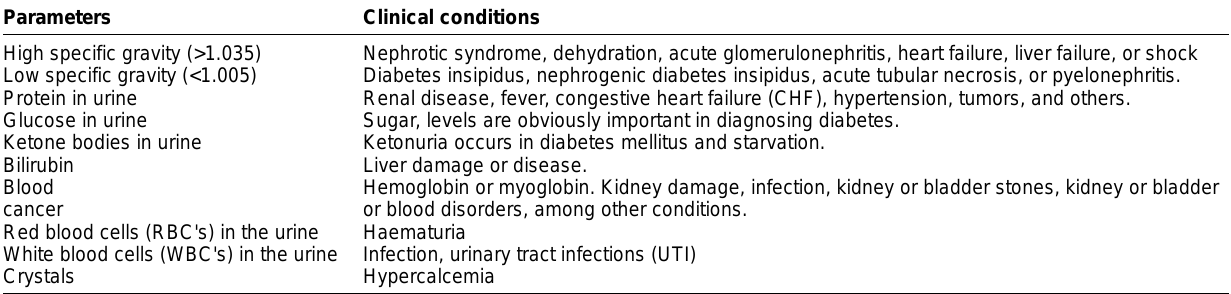
Table-3. Characteristics of urinary casts and conditions in which casts are typically observed [41] Type of casts